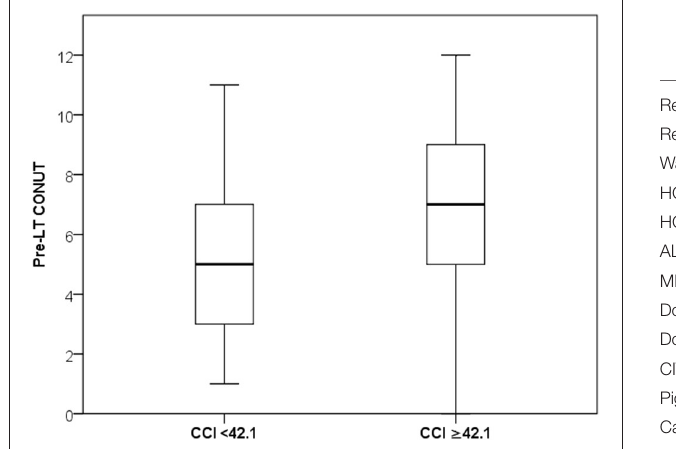
FIGURE 1 | Median and IQR values of CONUT in the low- and high-CCI groups.